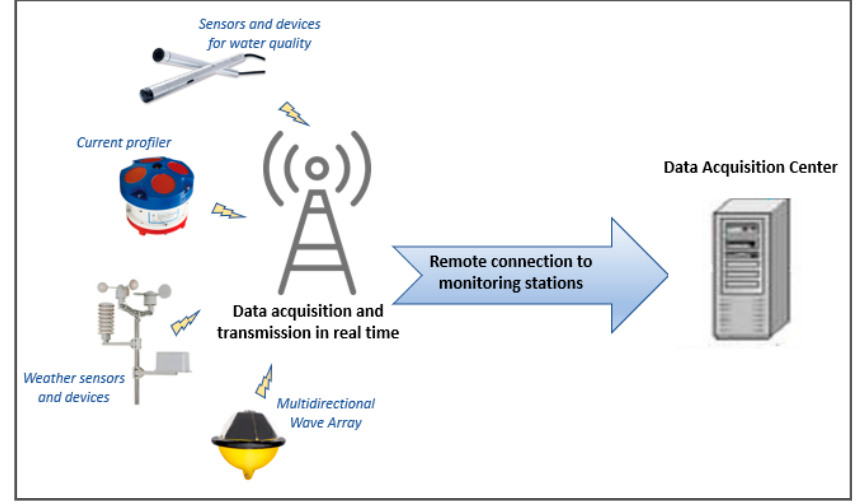
Figure 2. Conceptual scheme of the monitoring system MG.